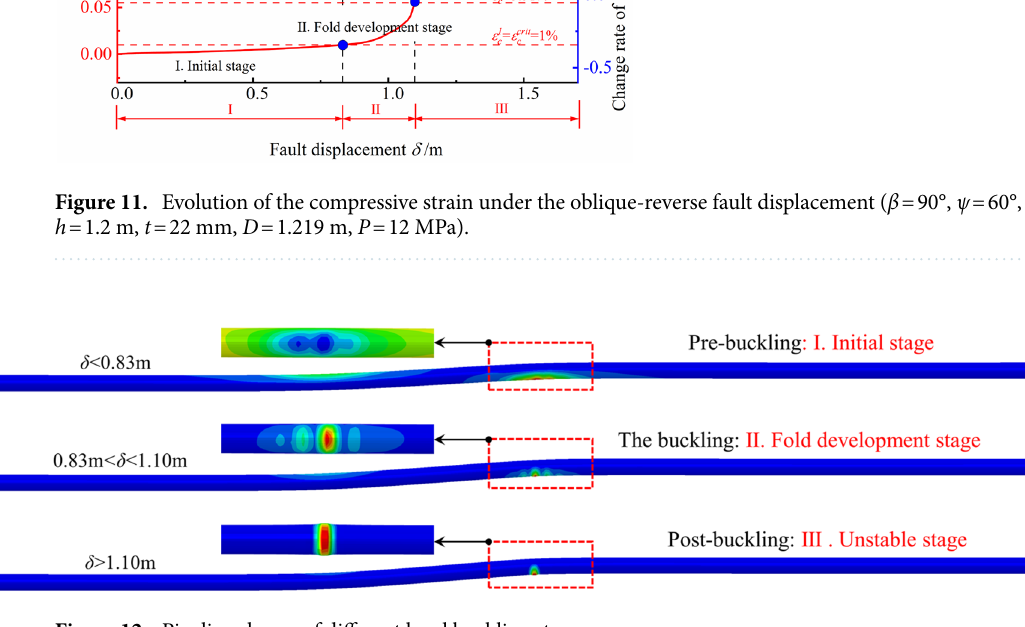
Figure 12. Pipeline shapes of different local buckling